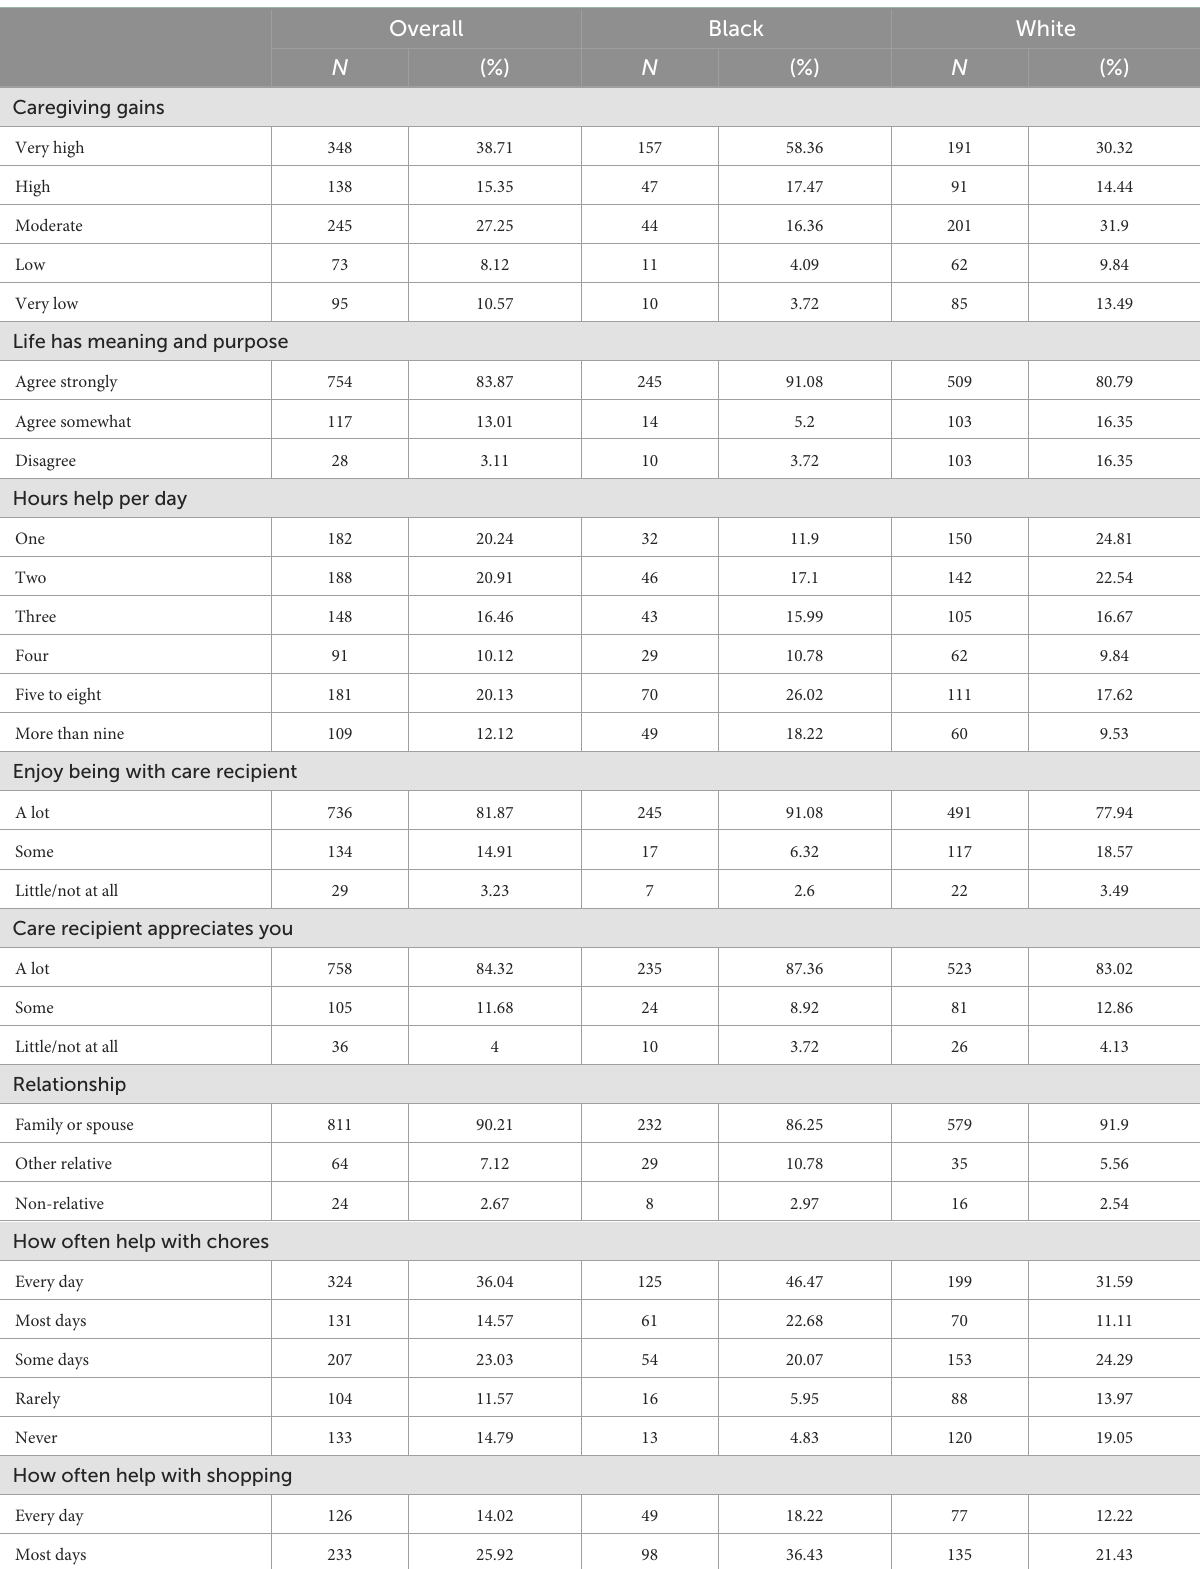
TABLE 1 Unweighted demographic characteristics. Overall Black White N (%) N (%) N